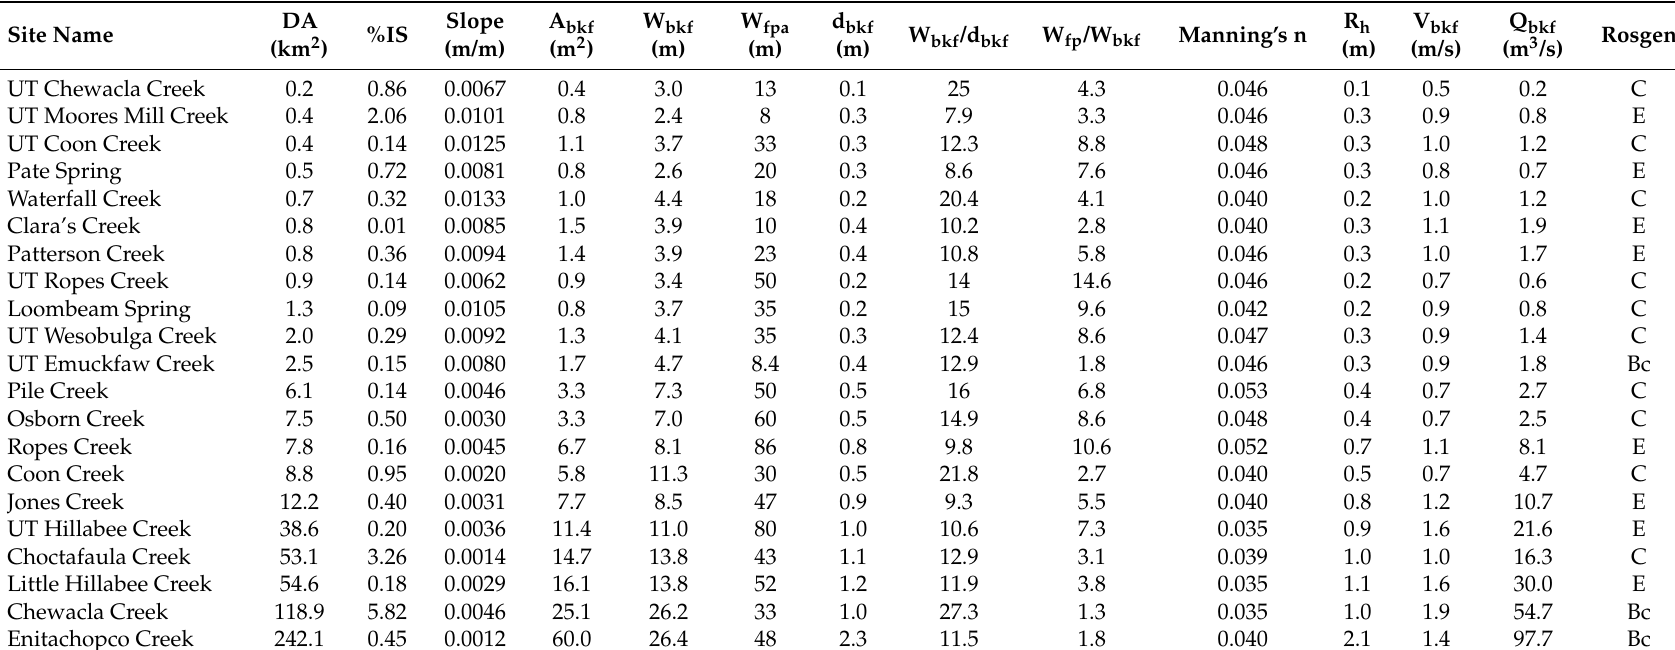
Table 1. Drainage area (DA), percent impervious surface (%IS), slope, bankfull dimensions, bankfull discharge parameters and Rosgen classification [11] for 21 reference streams of the Tallapoosa basin in the Piedmont of east Alabama. “UT” referes to “unnamed tributary”, see text for variable definitions. %IS determined from the 2011 National Land Cover Database